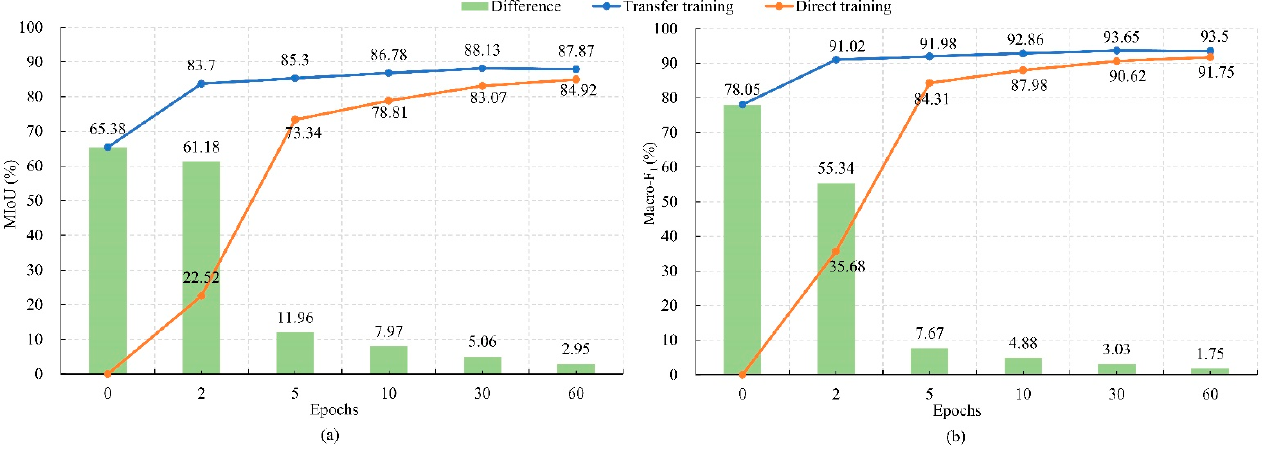
Figure 19. The accuracy curves of transfer training and direct training. In the charts, the disparities in accuracy between both training strategies were also plotted. ( a ) The MIoU values of both training strategies. ( b ) The Macro-F1 values of both training strategies.